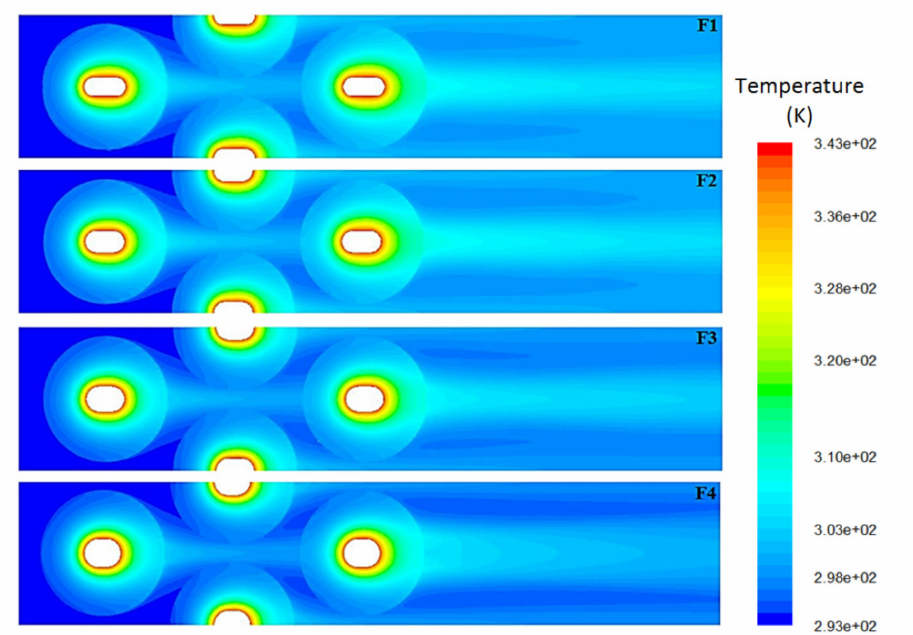
Figure 7. Temperature contours in the middle of the fin thickness for all the geometries of the flat